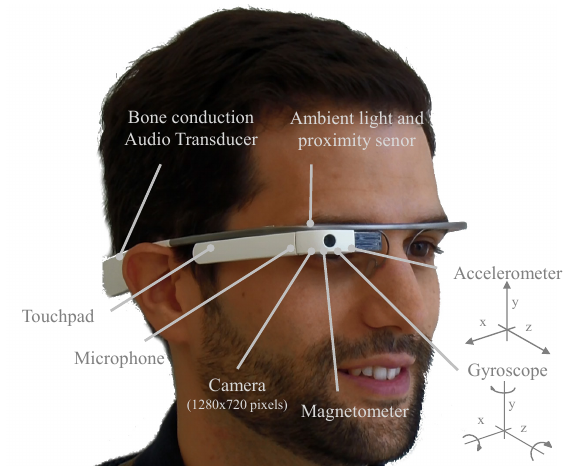
Figure 1. Head-mounted wearable device Google Glass and the locations of some of the main